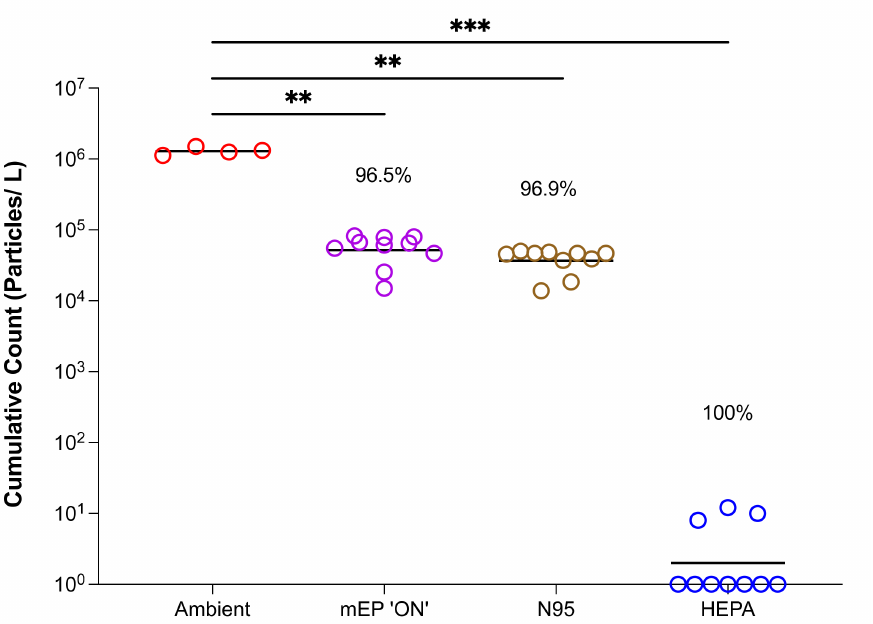
Figure 3. Particle counts of viral bioaerosols using the evaluation system within biocontainment. Counts from the energized mEP significantly reduced aerosol particles by a mean of 96.5% when compared to ambient (chamber) aerosol content; the N95 filter respirator significantly reduced particles by an approximately equivalent 96.9% when compared to ambient (chamber) particle content. The HEPA filter essentially removed all particles from the airstream. Colored open circles represent iterative run under named condition. Asterisks denote significance at p < 0.05 (**) or p < 0.005